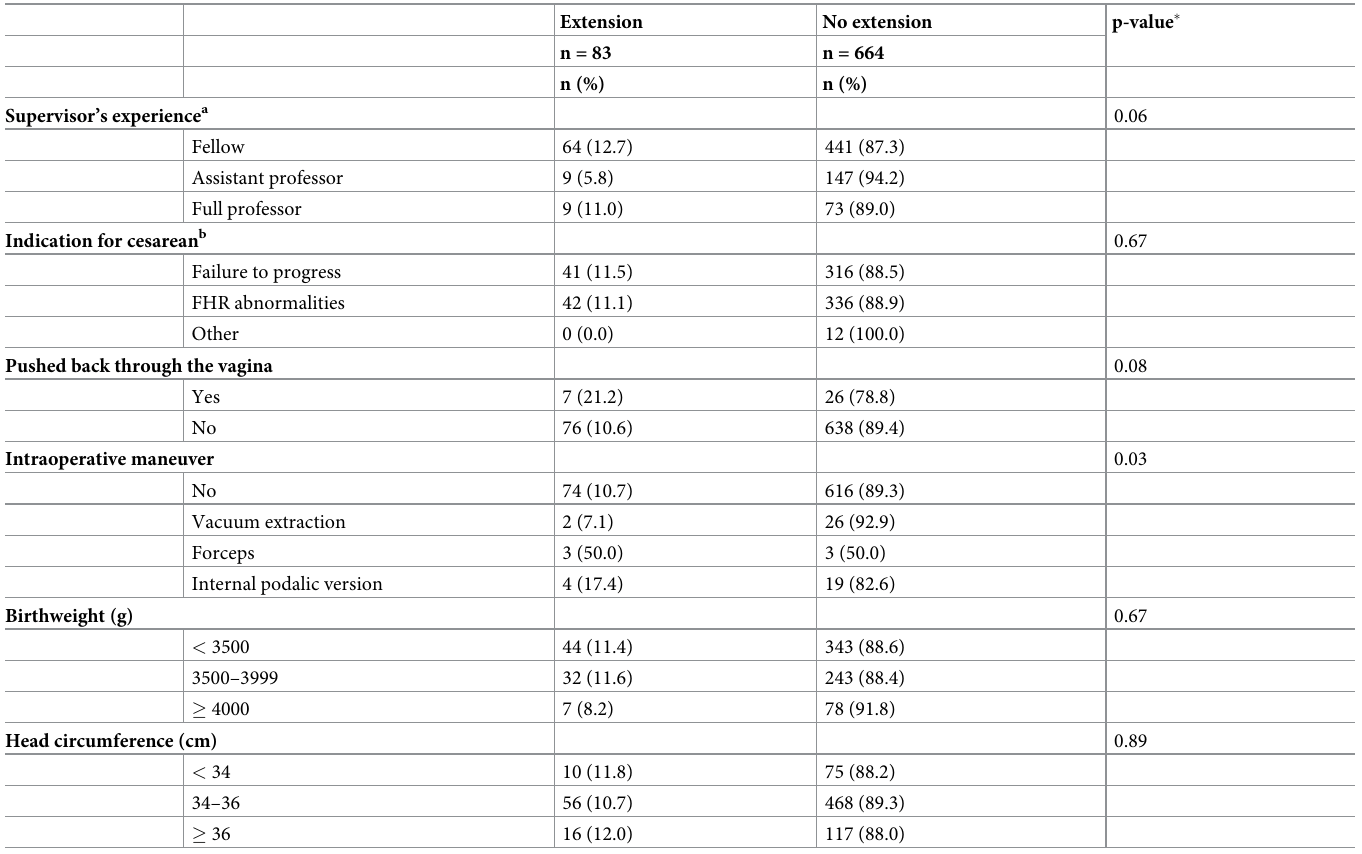
Table 3. Frequency of hysterotomy extensions according to intraoperative and neonatal